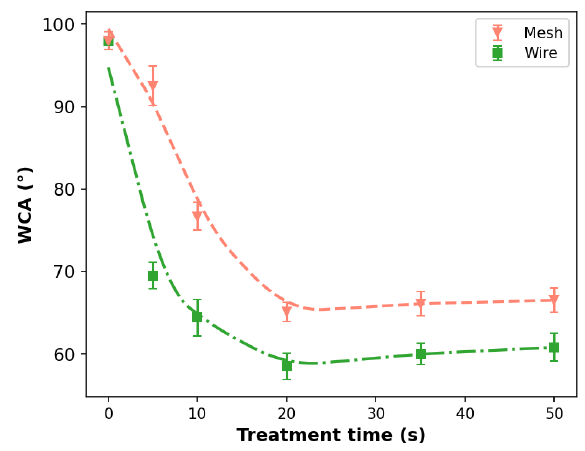
Figure 8. WCA measurements as a function of the treatment time. The distance between plasma outlet and target was 6 mm in this